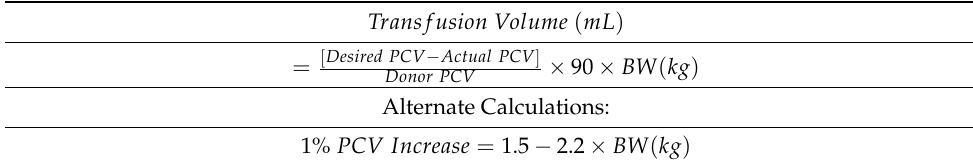
Table 2. Reference formulae for calculating required blood volumes.